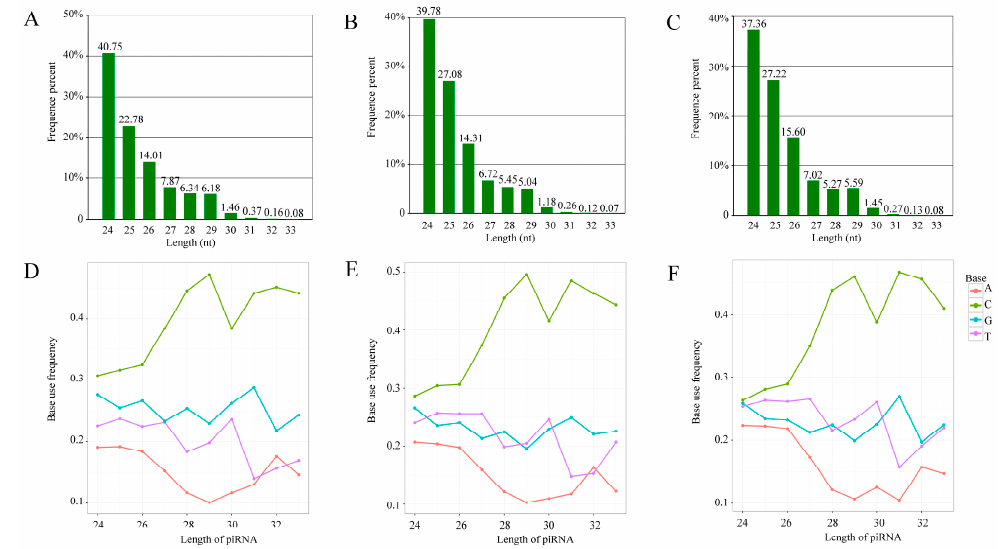
Figure 2. Length distribution and first base bias of A. c. cerana piRNAs. ( A – C ) Length distribution of piRNAs identified in Ac4, Ac5, and Ac6 groups. The number above each column indicates the percentage of piRNAs distributed at the specific length. ( D – F ) First base bias of piRNAs that were identified in Ac4, Ac5, and Ac6 groups. Each broken line represents the frequency of base use at the length distribution ranging from 24 nt to 32 nt.